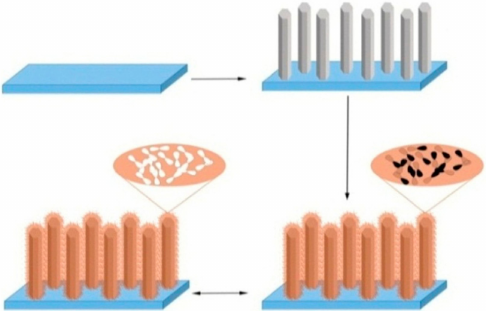
Figure 8. An array of zinc oxide nanorods coated with molecularly imprinted polymers for selective detection of epinephrine. Reprinted with permission from [98].